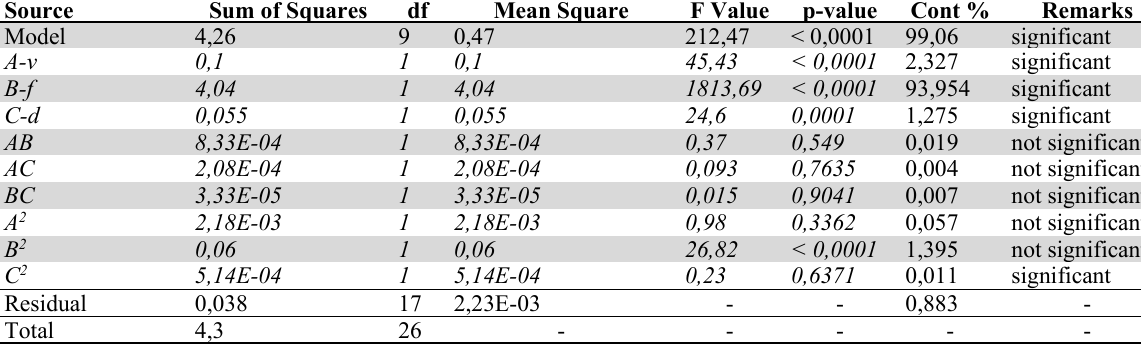
Analysis of variance results of surface roughness Ra using Coated inserts Source